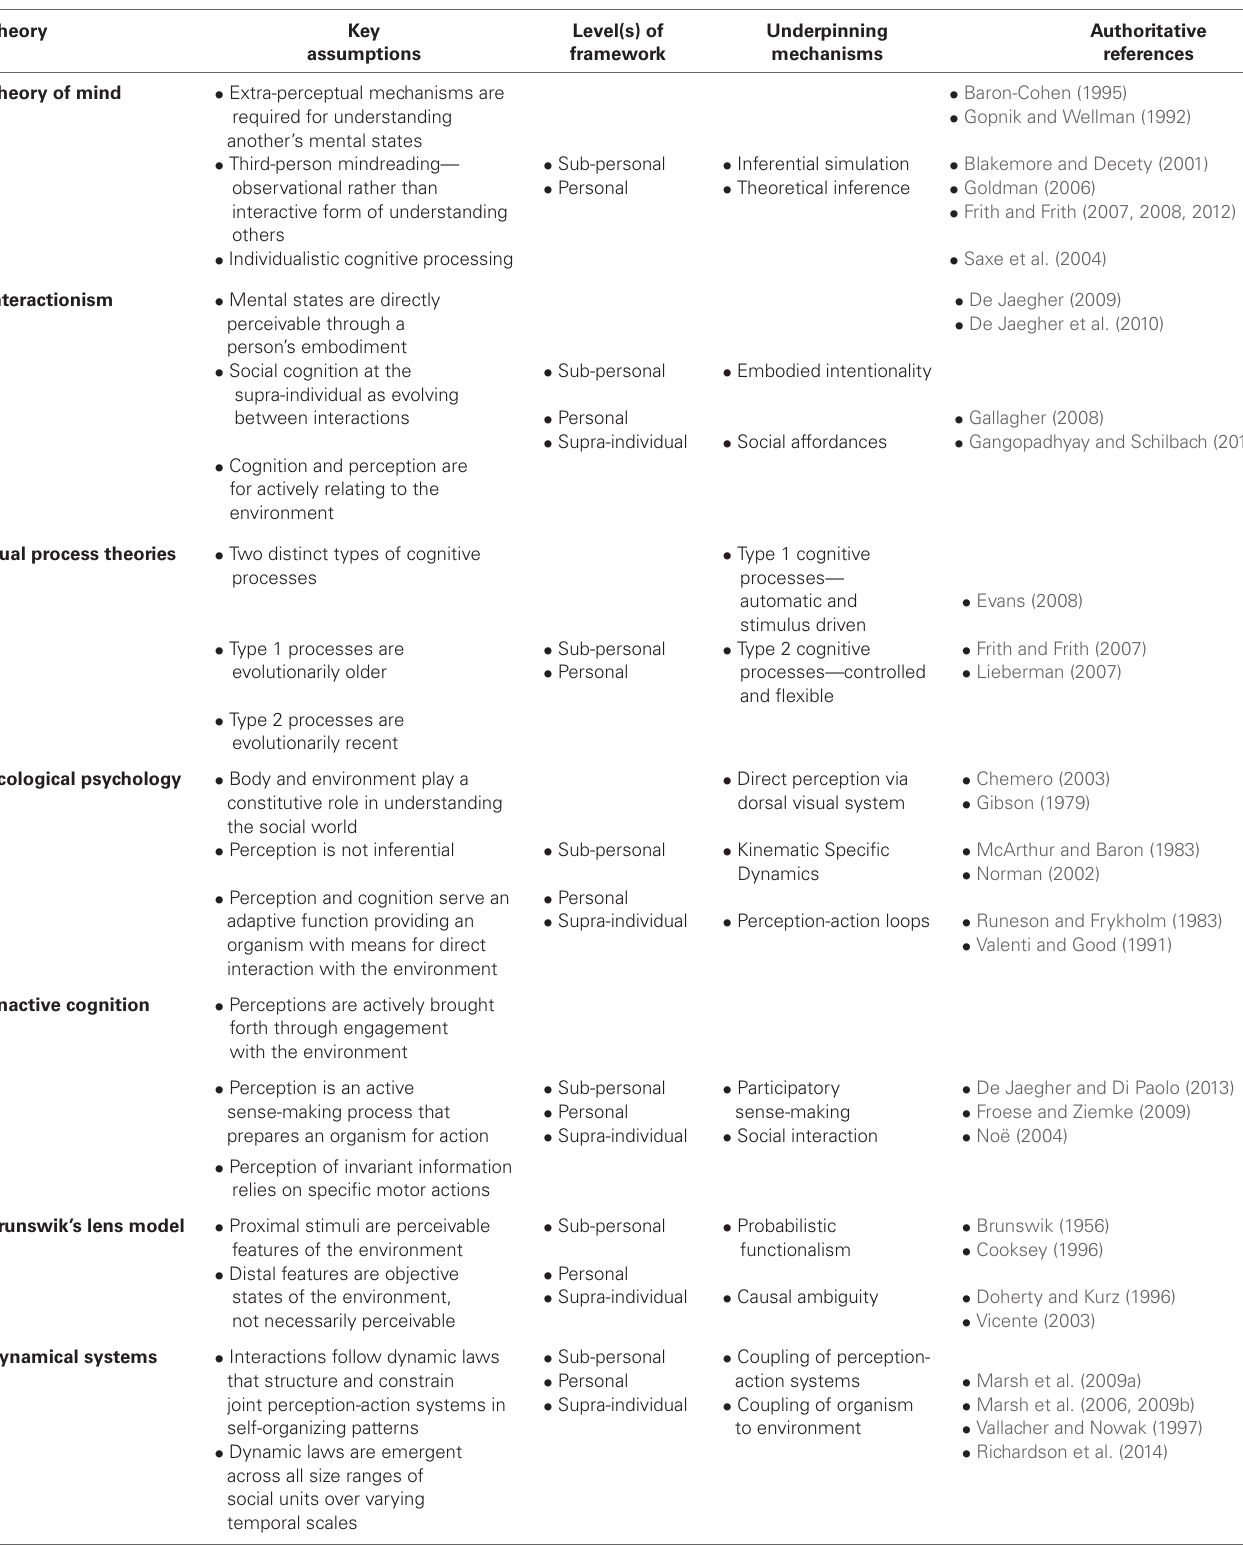
Table 1 | Theoretical perspectives relevant to integrative account of social cognition . Theory